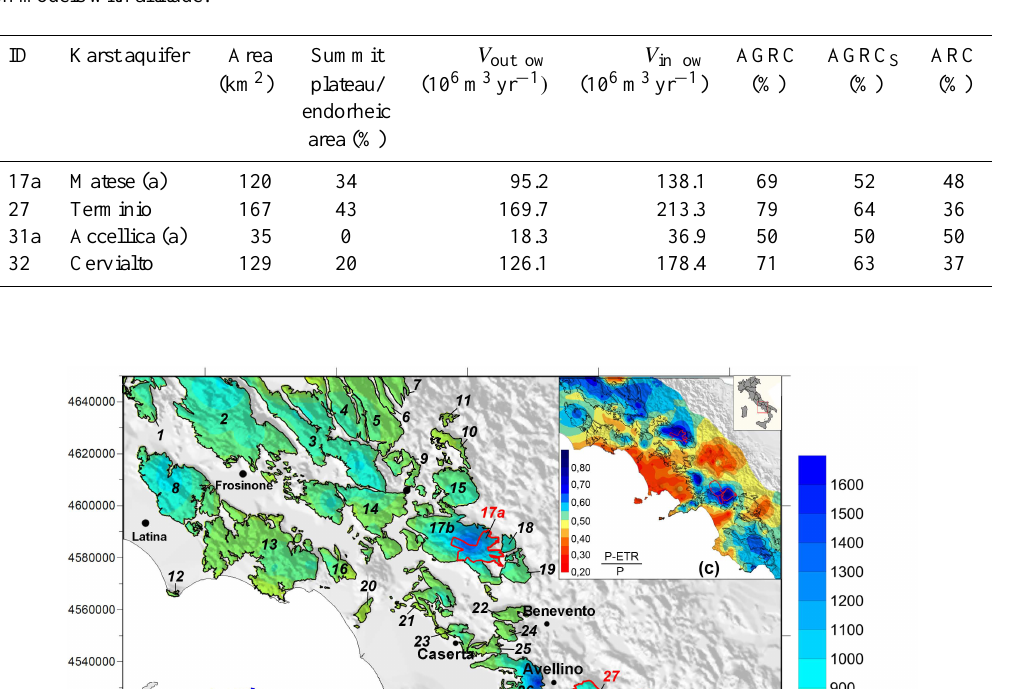
Table 1. AGRC and mean AGRC S estimation for the investigated sample karst aquifers. Values are related to the mean value of the P − ETR linear regression models with altitude.